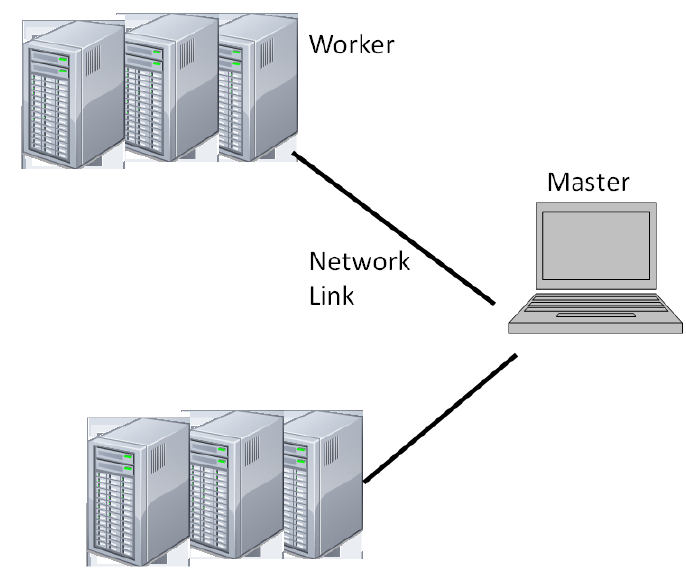
Figure 1. A Star-Topology Computing Platform